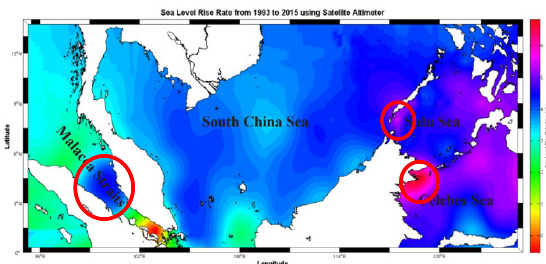
Figure 7. Map of sea level rate over Malaysian Seas (Hamid et al., 2018)